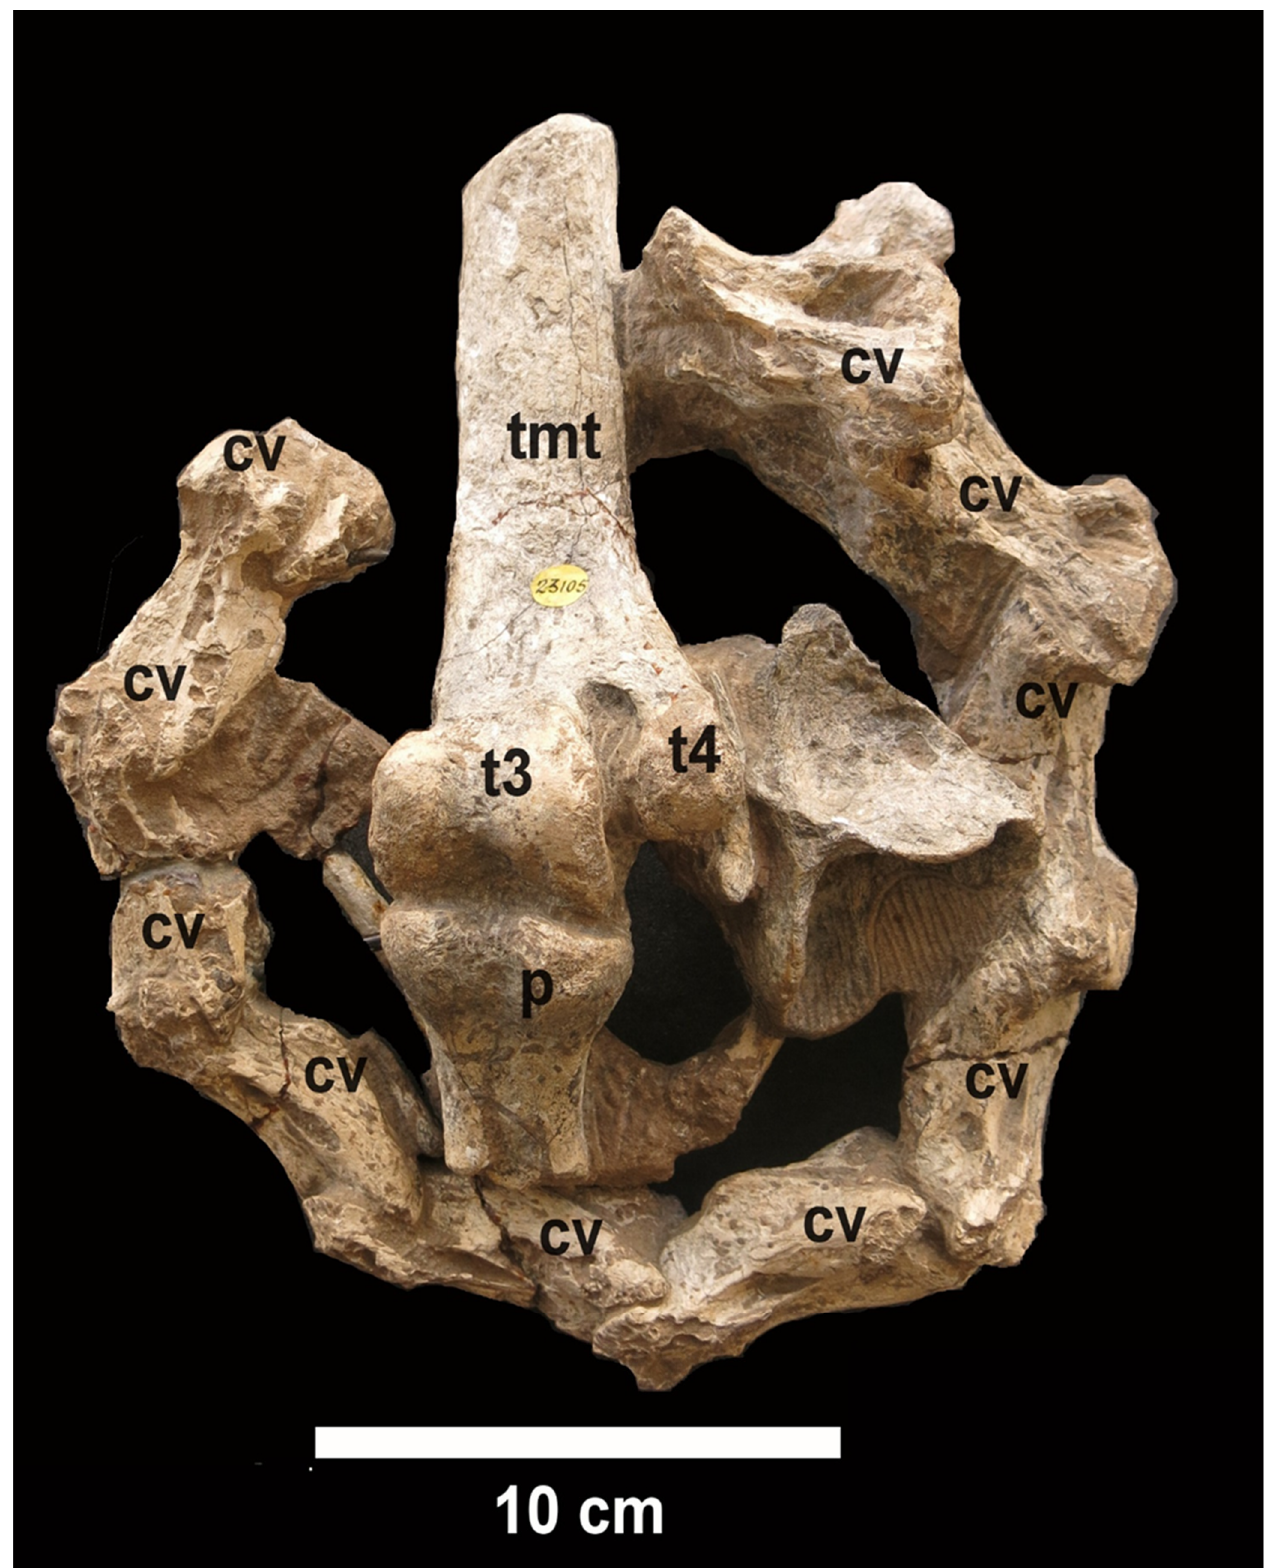
Figure 1. Type specimen of Struthio asiaticus Milne-Edwards, 1869–1871, NHMUK PV OR 23105, with the tarsometatarsus and phalanx in cranial view, showing the series of cervical vertebrae. Specimen collected by J. Colvin, presented to the British Museum in 1842; cv: cervical vertebrae; p: first phalanx of third toe; tmt: tarsometatarsus; t3: trochlea for third toe; t4: trochlea for fourth toe.